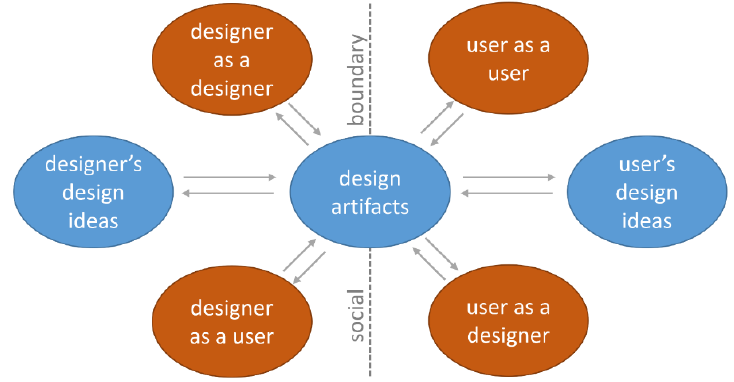
Figure 2. Model of designer-user interactions in visual analytics tool design (after Figure 4 in Park and Boland, 2011,